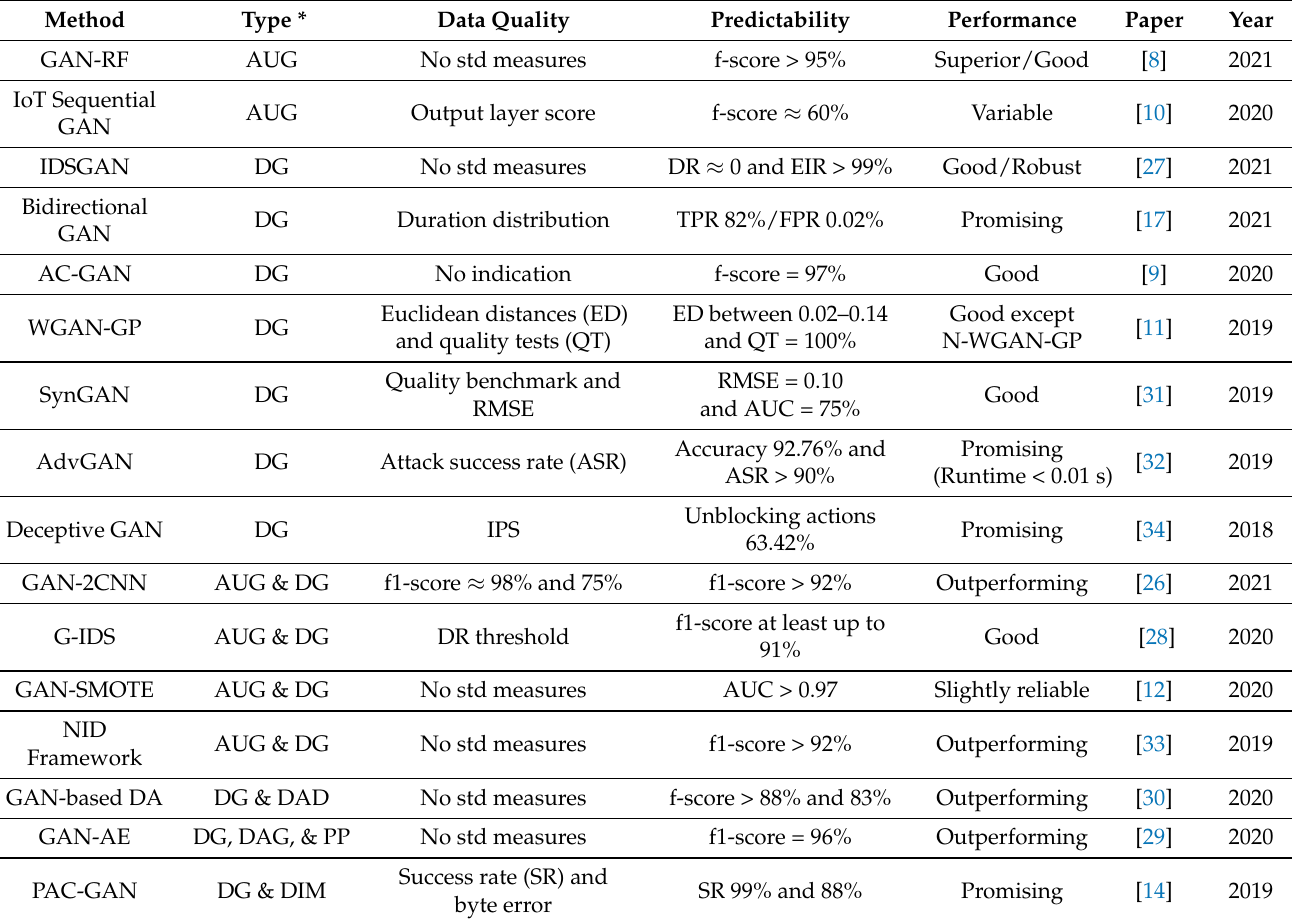
Table 3. Subgroup Analysis Based on the Evaluation Results of Data-driven Learning Methods.